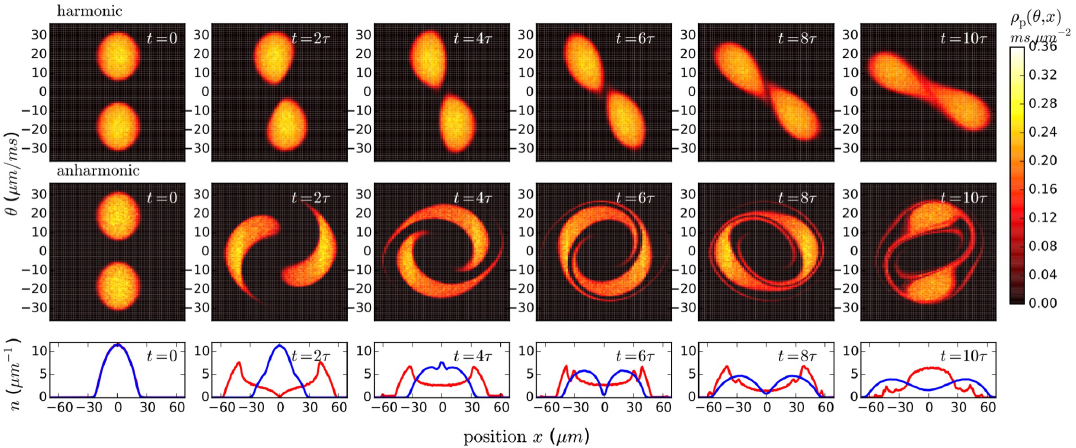
Figure 2: Same as Fig. 1, on a larger time window. In the harmonic case, the two blobs in the ( x , θ ) -plane keep rotating around each other after several trap periods. ( θ , x ) is strongly stirred up after a few In the anharmonic case, the distribution ρ p trap periods, and it goes to stationary state that looks rotationally invariant in the ( x , θ )